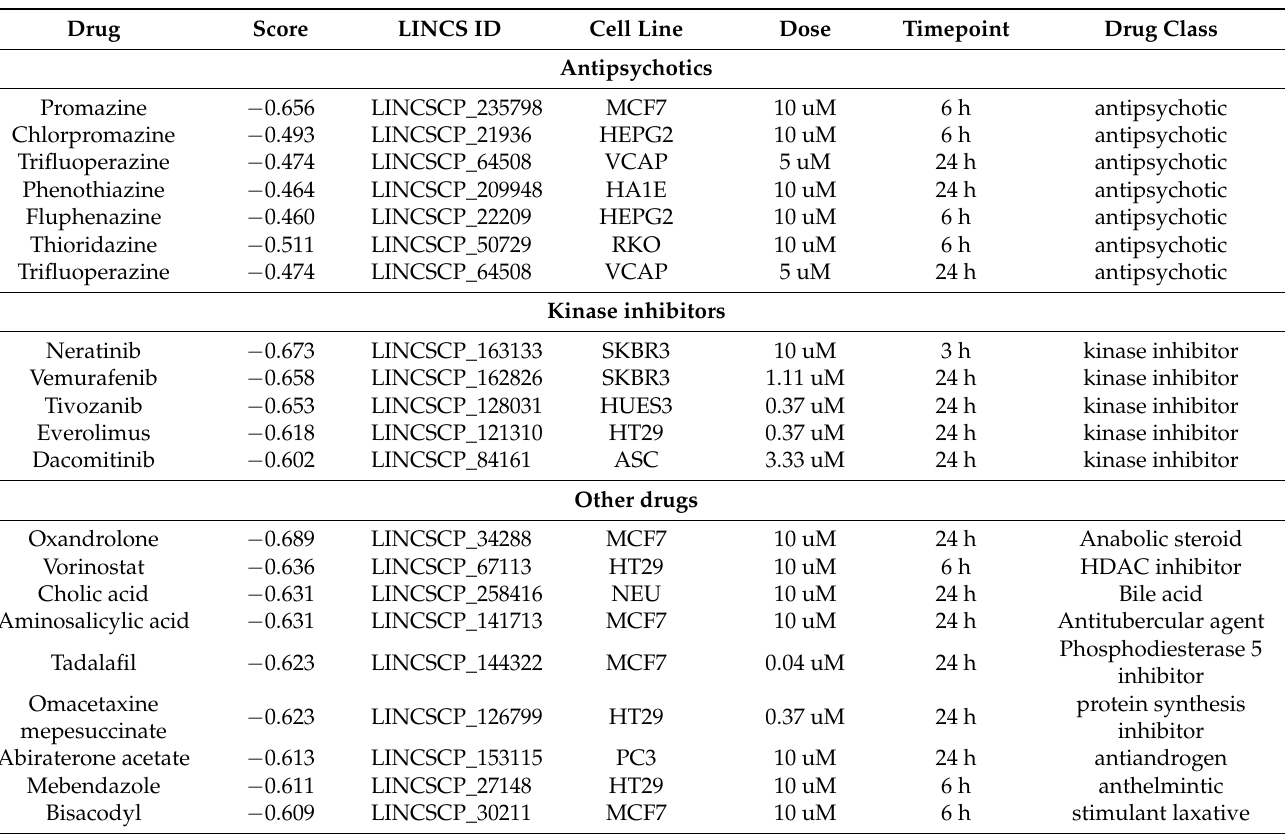
Table 1. FDA approved drugs that are discordant (discordance score < − 0.6) with the AST_hiPSC_SCZvHC gene signature. Drugs were identified using the iLINCS repository of chemical perturbagens. A number of antipsychotics, kinase inhibitors and “other” drugs were